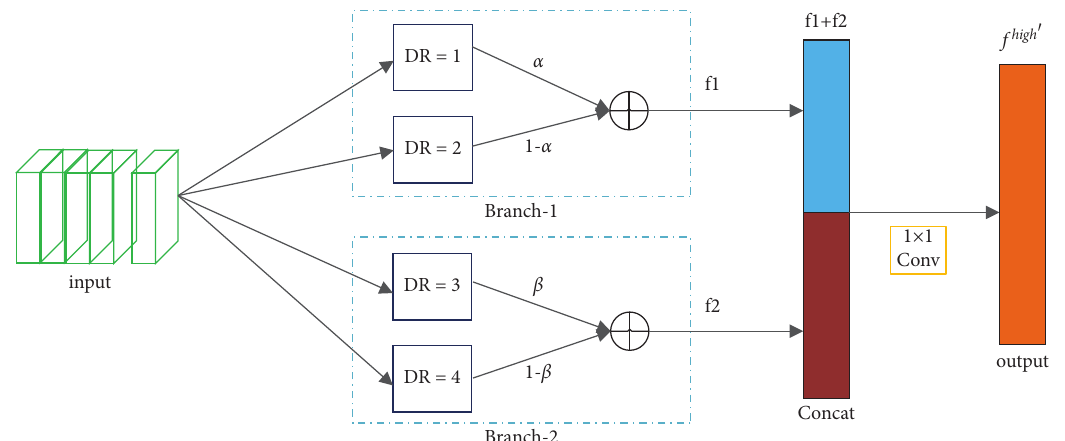
Figure 2: The scale invariance processing